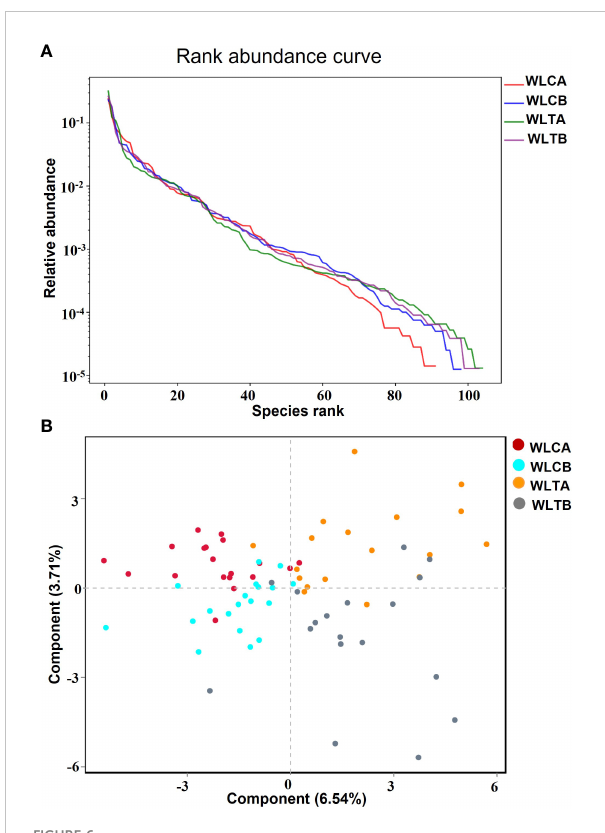
FIGURE 6 (A) Rank abundance curve. Each curve represents a group; placebo group (WLCB (baseline), WLCA (post treatment)) and treatment group (WLTB (baseline) and WLTA (post treatment)). (B) PLS-DA plots based on unweighted unifrac metrics. Each symbol represents a sample from the placebo group or treatment group,